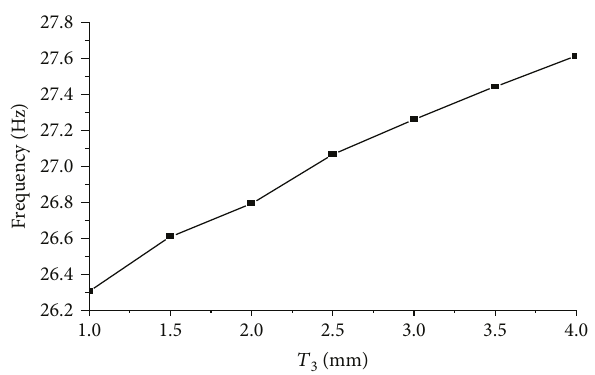
Figure 19: In fl uence of the stringer thickness on the fi rst modal frequency of the equipment